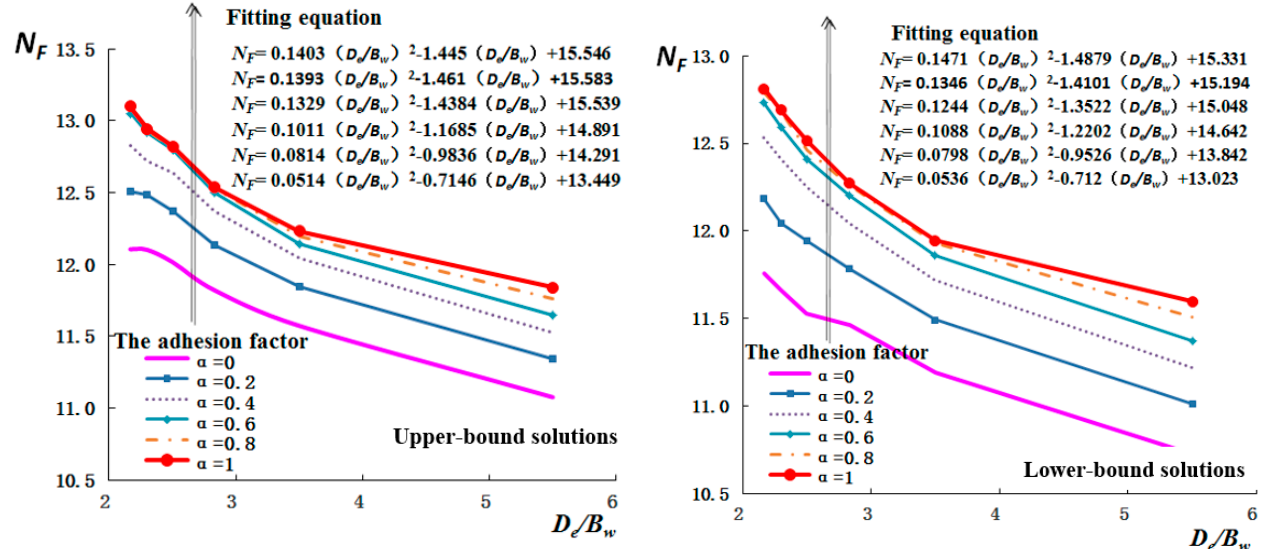
Figure 5. Relationship between the normalized ultimate lateral capacity ( N F ) of the three-wing pile and the wing–diameter ratio ( D e /B w ) when lateral-load angle β = 0. ( Top ) Upper-bound and ( Bottom ) lower-bound solutions from limit analysis with different pile-soil interaction coefficients (adhesion factors).